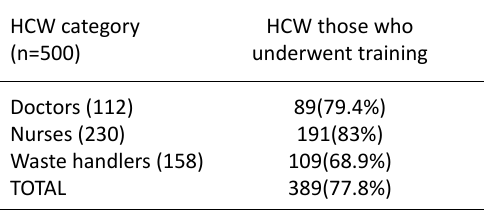
Table 1. Health care workers who underwent BMWM